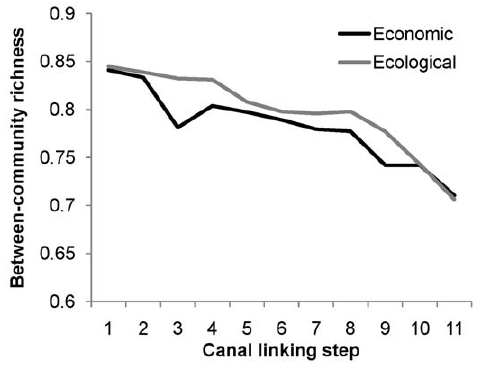
Figure 6. Between-community diversity for each linking strategy. The change in between-community diversity (i.e., b diversity) at each linking step is generally smaller for the ecological than the economic linkingstrategies.Note that thecanal added at steps 1–9 (but not 10 or 11) differ between strategies (compare canal implementation in Fig. 3).